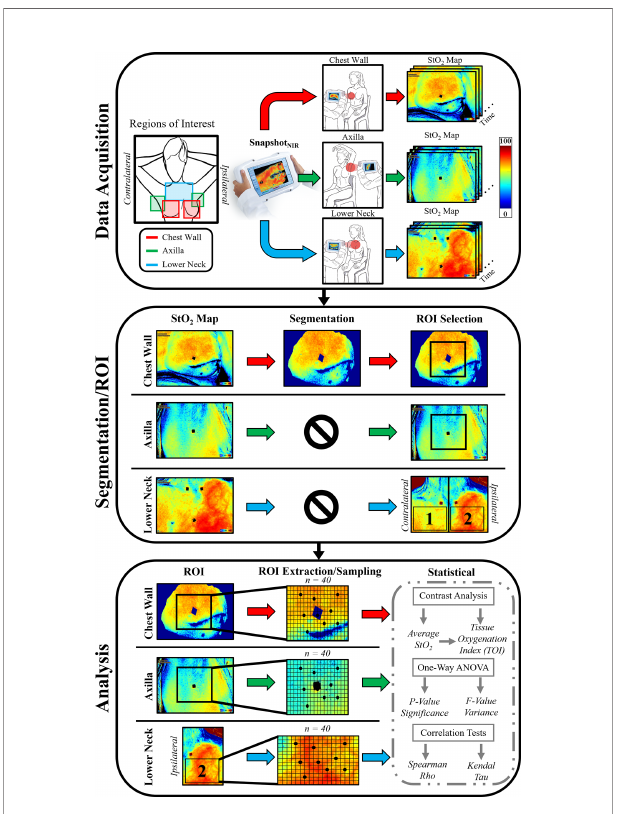
FIGURE 1 | Schematic demonstrating the work fl ow and methodology of the